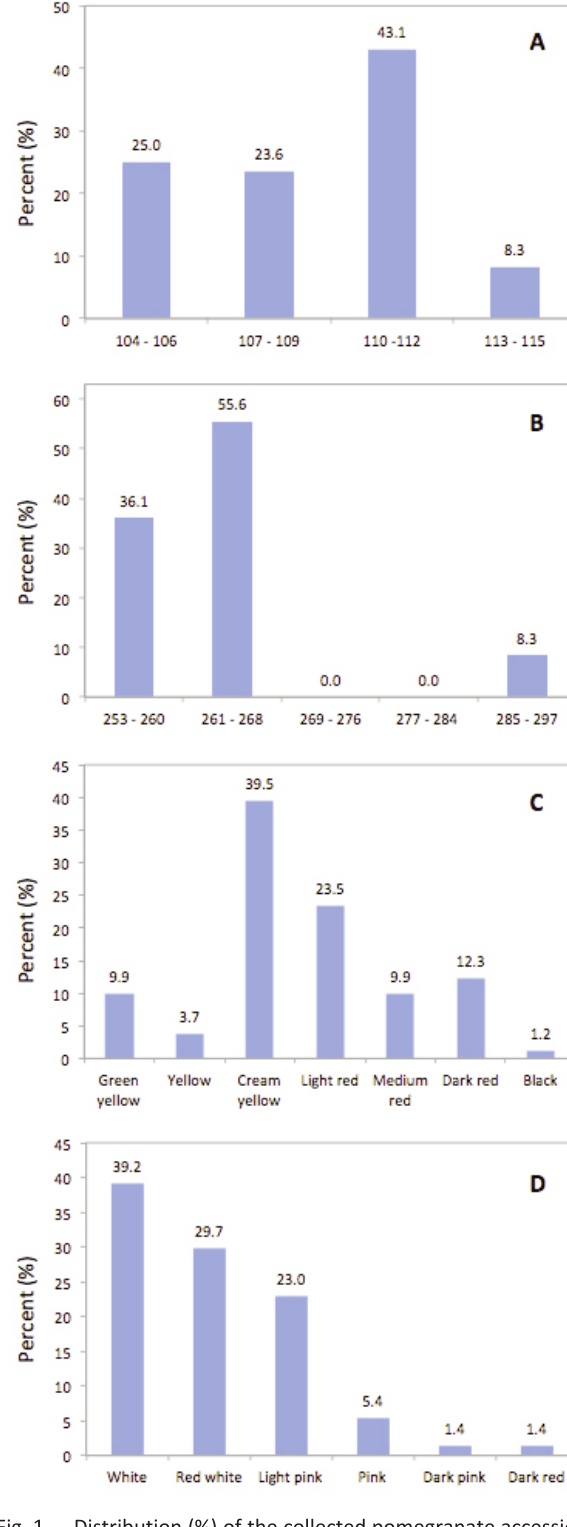
Fig. 1 - Distribution (%) of the collected pomegranate accessions in relation to: a) beginning of flowering time (day of the year); b) beginning of ripening time (day of the year); c) fruit skin color and d) fleshy part of seed (aril)